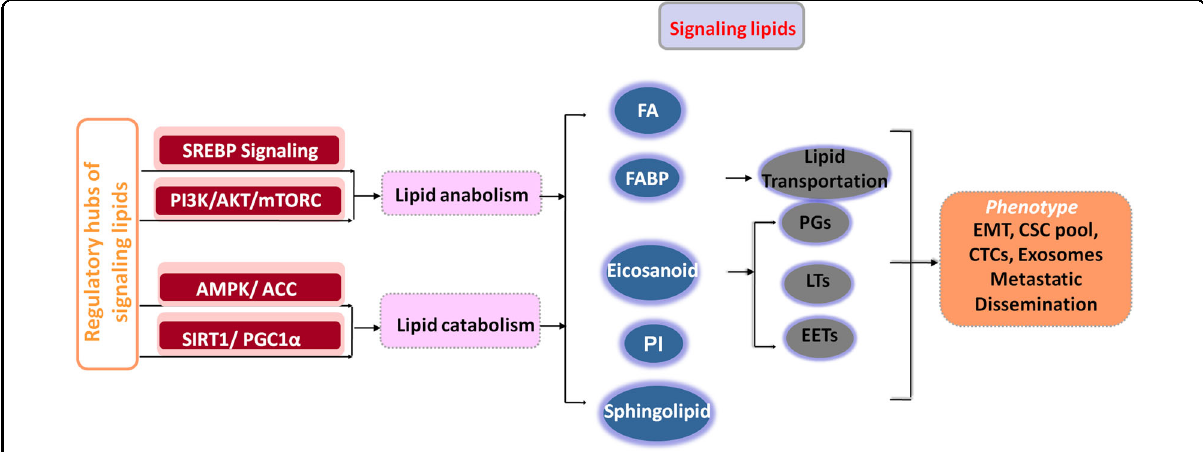
Fig. 2 Connections among lipid regulatory pathways, signaling lipids and the invasive and metastatic phenotypes of tumor cells. SREBP signaling and the PI3K/AKT/mTORC axis are mainly responsible for lipid anabolic metabolism, and the AMPK/ACC and SIRT1/PGC1 α axes contribute to lipid catabolic metabolism in tumor cells. Accumulating signaling lipids, such as FAs, eicosanoids, PIs, sphingolipids and FABPs, represent causal factors for the cancer cell EMT program, the maintenance of the CSC subpool, the increased number of CTCs and the metastatic phenotype. CSC cancer stem cell, CTC circulating tumor cell, EETs epoxyeicosatrienoic acids, EMT epithelial – mesenchymal transition, FAs fatty acids, FABPs fatty acid- binding proteins, LTs leukotrienes, PGs prostaglandins, PIs phosphatidyl inositides, ACC acetyl-CoA carboxylases, Alox5 arachidonate 5-lipoxygenase, AMPK AMP-activated protein kinase, COX cyclooxygenase, FABPs fatty acid-binding proteins, LOX lipoxygenase, mTOR mammalian target of rapamycin, PG prostaglandin, PI3K phosphoinositide 3-kinase, SREBP sterol regulatory element-binding proteins, SPHK1 sphingosine